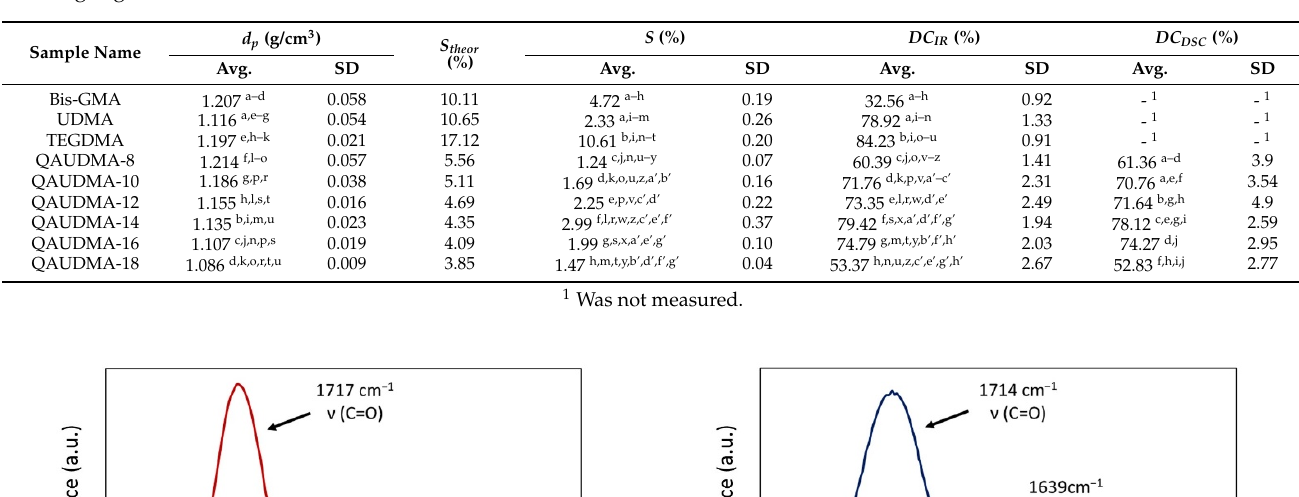
Table 2. The properties of QAUDMA polymers. Couples that revealed statistically significant results ( p < 0.05) are highlighted with the letters.